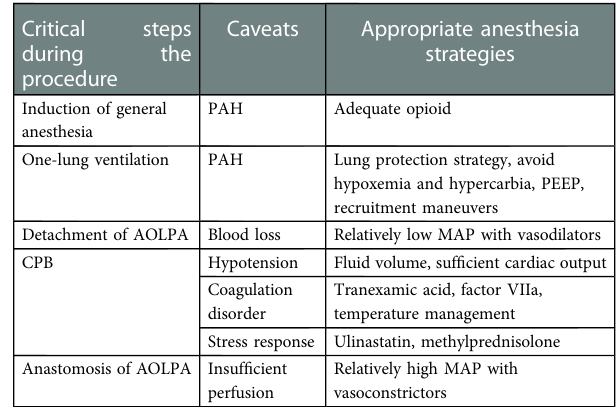
TABLE 2 A summary on the perioperative anesthesia management for